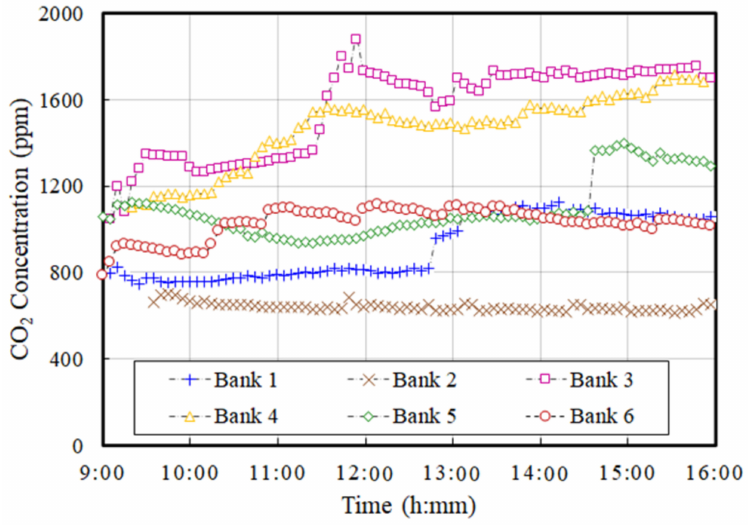
Figure 3. Time-series plot of CO 2 in bank vault, each point at 5-min interval over the study period. Upon analyzing the graph, it becomes evident that the majority of the CO 2 concentra- tion patterns observed have shown an upward trend. The concentration of CO 2 at